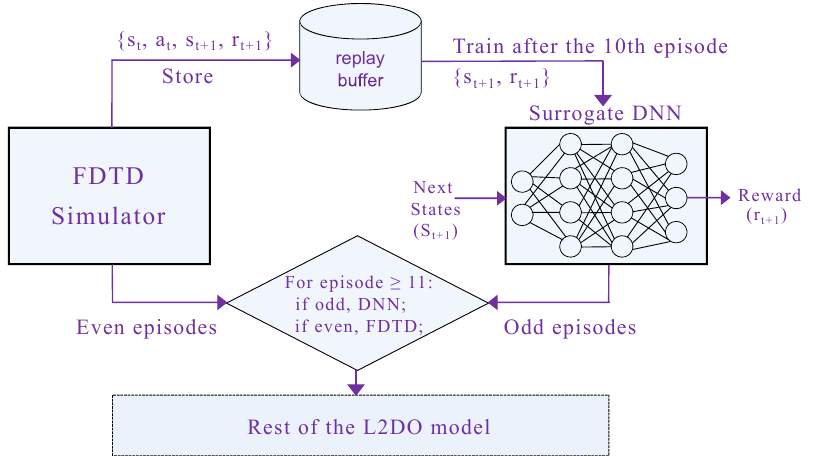
Figure 3: The novel DNN/Simulator Alternating technique (DSA), where the surrogate DNN and the actual FDTD simulator take turns to function as the environment of L2DO. Input to the DNN is next states and output is rewards. The DNN is only activated after the first E episodes, which is set to be 10 for illustrative purposes in this diagram. Right before the activation, the DNN is trained on data samples collected from FDTD during the first E episodes. After the activation, the DNN and the simulator alternate between odd and even episodes, respectively. Samples during the episodes when the simulator is used are still stored to the replay buffer for continuously training the DNN down the road. DSA is expected to cut down training time by a large